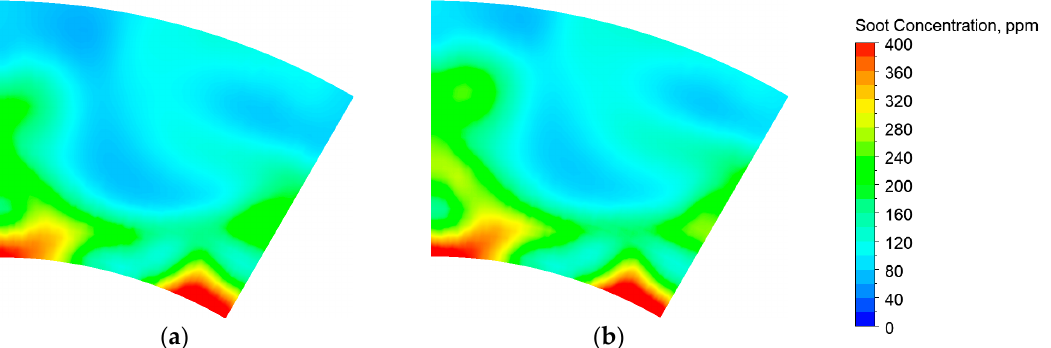
Figure 12. Combustor outlet soot concentration contour with: ( a ) uniform outlet; ( b ) non-uniform outlet pressure boundary condition.